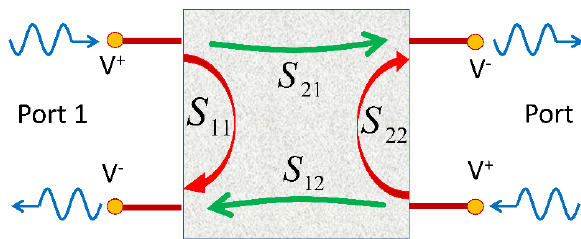
Figure 1: The schematization of the signals emitted by a Vector Network Analyzer.